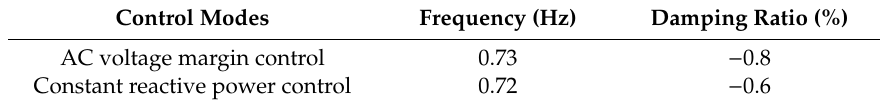
Table 2. The impact of reactive power control modes on damping characteristic of power